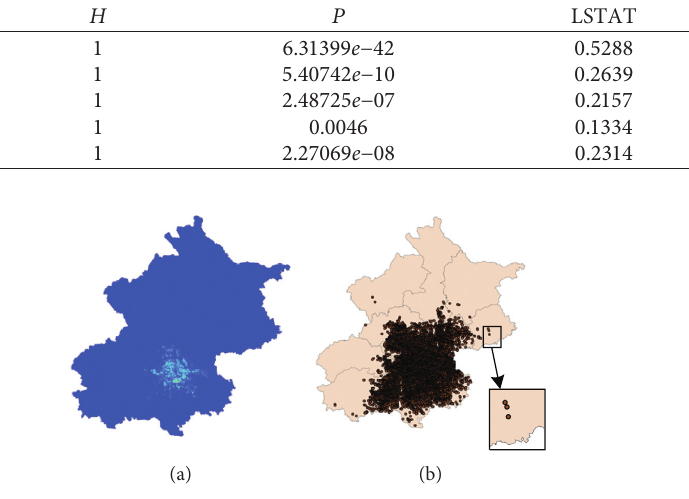
Figure 8: (a) Heatmaps and (b) travel hotspots of bike sharing.